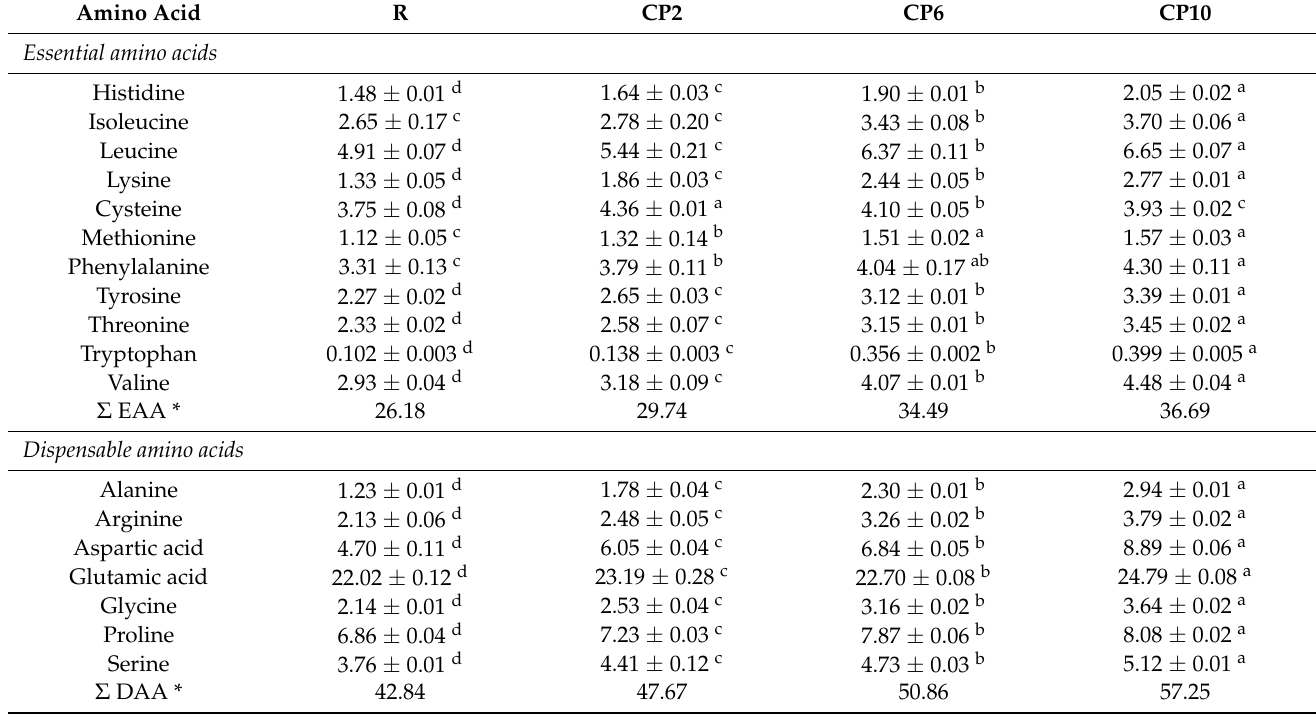
Table 5. Amino acids profile expressed as mg per g of